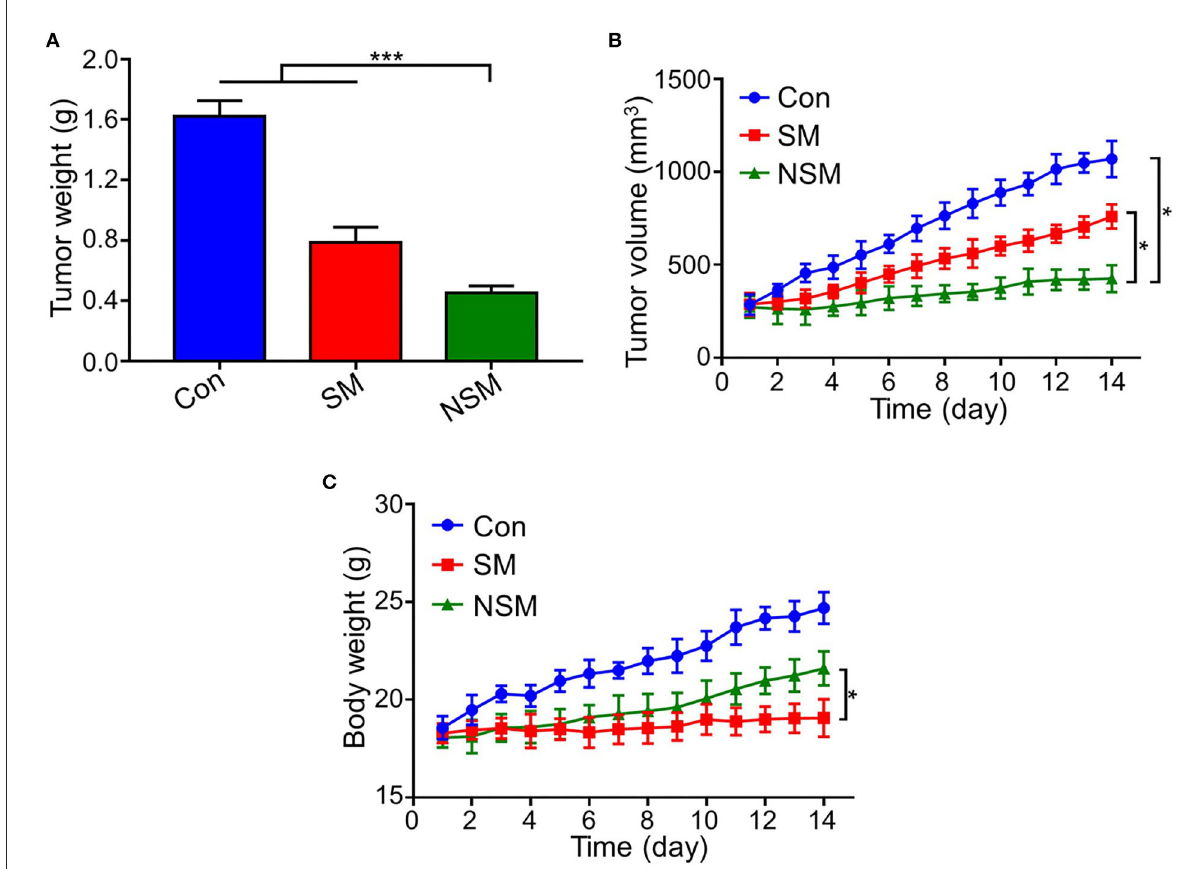
FIGURE4 Antitumor efficacy of NSM in subcutaneous colon cancer mice model. (A) Tumor weight. (B) Tumor volume. (C) Body weight of mice. * and *** represent P < 0.05 and P < 0.001,